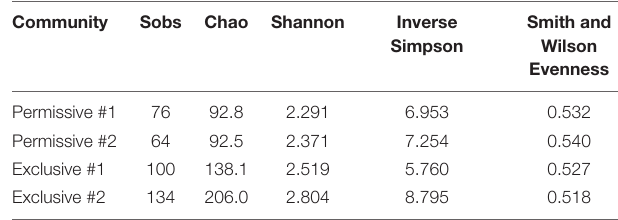
TABLE 2 | Diversity indices for Salmonella exclusive or permissive cecal